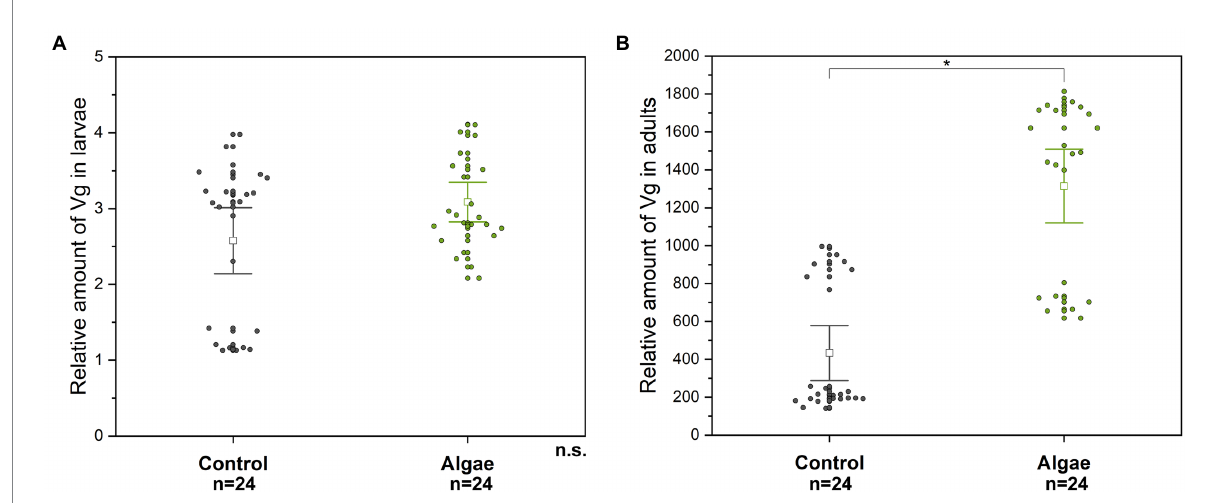
FIGURE 1 The relative level of Vg in larvae (A) and adult (B) hemolymph. A significant difference ( p < 0.004) between the groups (Control, Algae) is indicated by an asterisk above the means. n.s. – non-significant difference. Control – bees from colonies fed with APIVITAL® sugar syrup. Algae – bees from colonies fed with 10% (w/v) Chlorella powder in APIVITAL® sugar syrup.